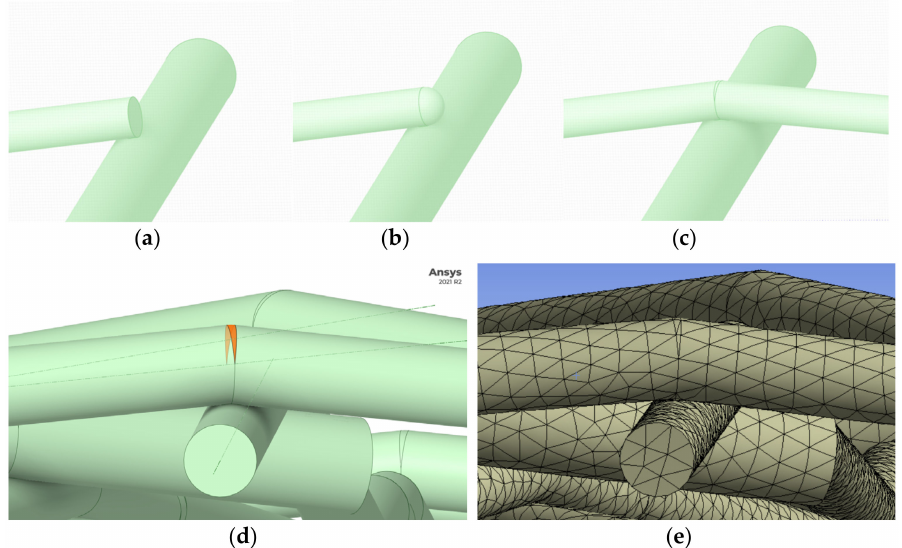
Figure 5. Spherical joints at the fiber segment connections. ( a ) New fiber segment resting on previous fiber. ( b ) Spherical joint at segment endpoint. ( c ) Continuation from joint. ( d ) Completed fiber with highlighted joint. ( e ) Completion of